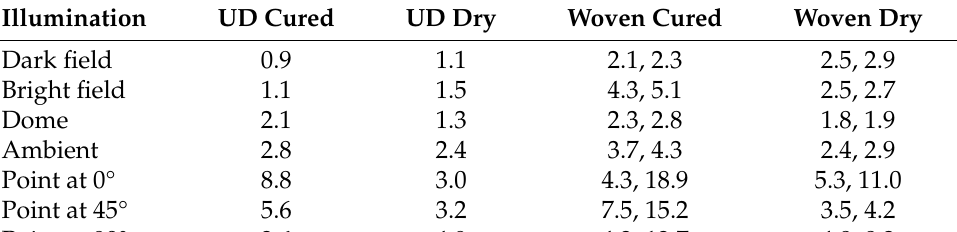
Table 3. Standard deviations (°) of measurements within the “full” ROI (see Figure 9) for various illumination conditions (23 mm lens). For the woven case, the values are simply given with the lowest number followed by the highest.